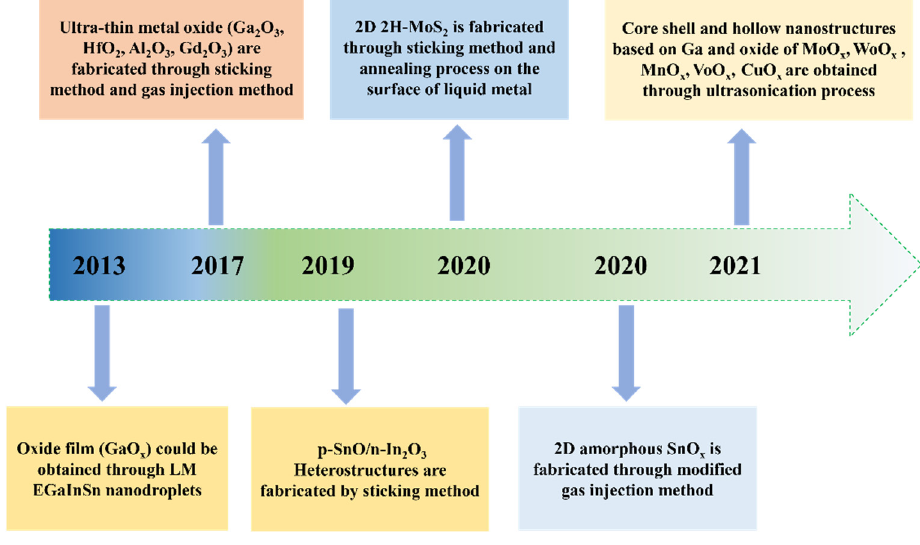
Figure 1. Timeline of Landmark Academic Works About 2DMOs from LM.